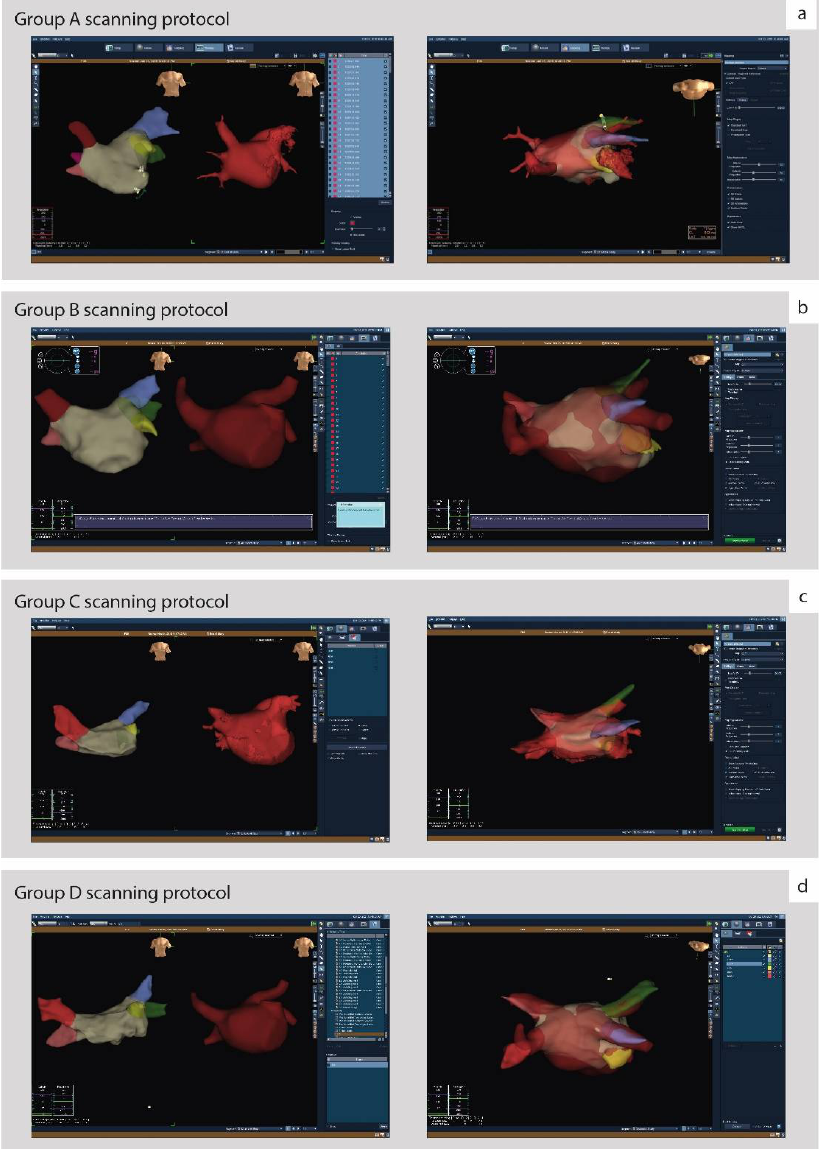
Figure 3. Parallel views of 3D electroanatomical maps with CT-generated LA models. From left to right, each subfigure represents the patient’s electroanatomical maps (beige with PVs colorized), the corresponding CT LA model (red) and the fusion of the two. ( a ) Group A (current tube 33 mAs); ( b ) Group B (current tube 67 mAs); ( c ) Group C (current tube 135 mAs); ( d ) Group D (current tube 600 mAs).